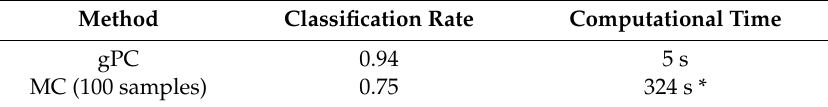
Table A2. Comparison results between gPC and